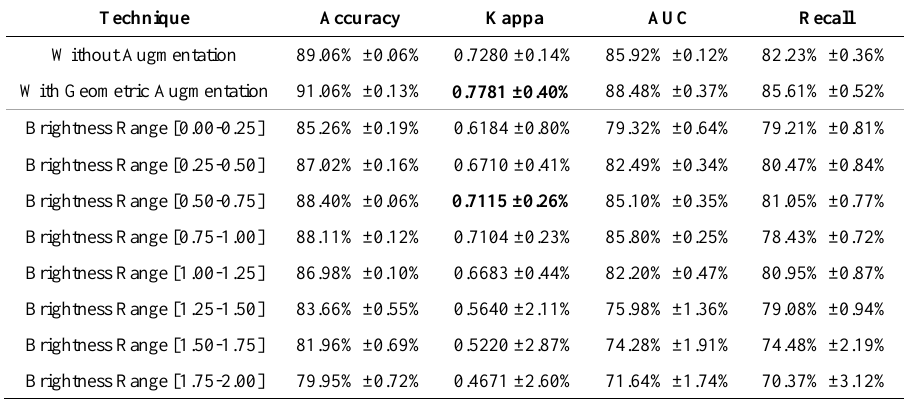
Table 2. Results of DenseNet121 network. (± 95% confidence interval over repeated trials)